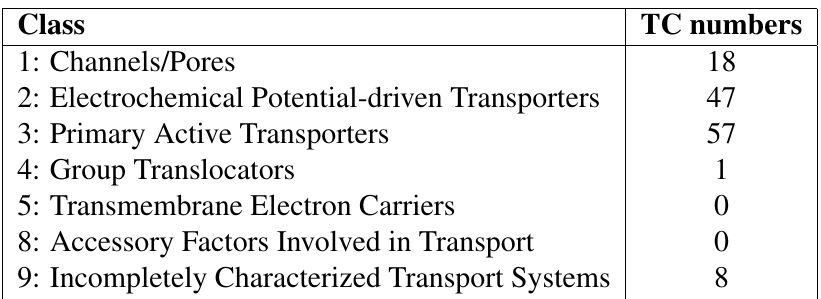
Table 4: Distribution of TC numbers in the TCDB